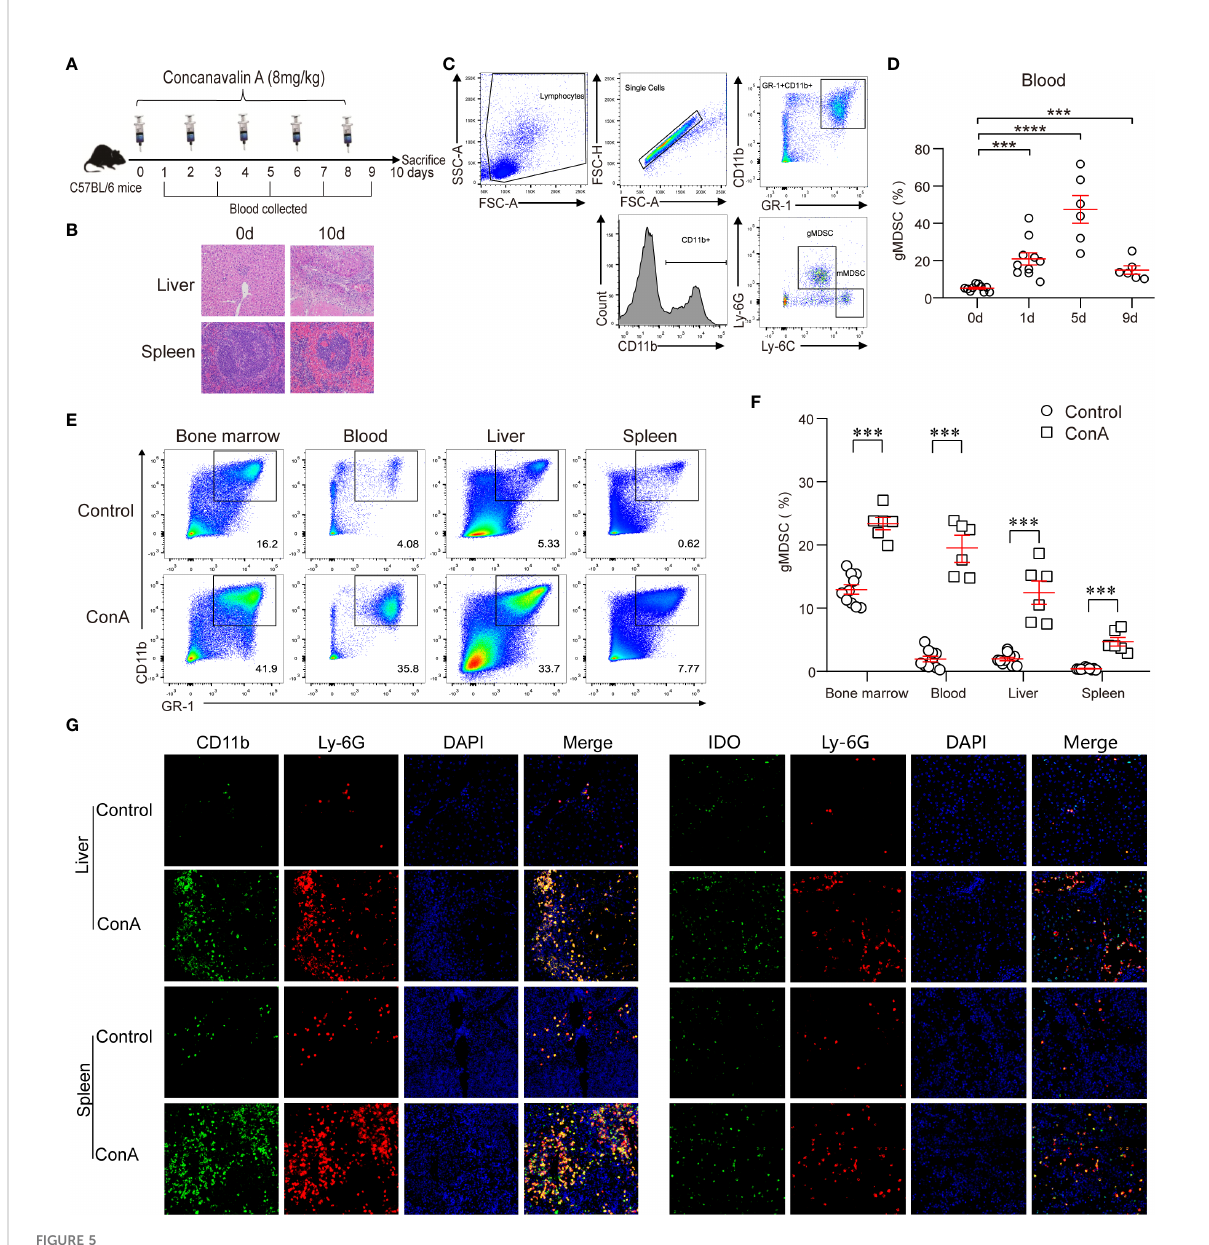
FIGURE 5 Increased gMDSC and IDO + gMDSC proportions in the ACLF mouse model. (A, B) Flow chart (A) , along with liver and spleen pathology (B) of the ACLF mouse model generated from continuous ConA injection. (C) Representative FACS plot of gMDSC and mMDSC. (D) Dynamic changes to gMDSC after continuous ConA injection. (E, F) Representative FACS (E) and cumulative dot plot (F) of gMDSC in bone marrow, blood, liver, and spleen of ACLF mice. (G, H) Representative double epitope immunostaining of liver and spleen tissue from ACLF mice for CD11b (green) and Ly- 6G (red); Ly-6G and IDO; Scale bar, 70×. ***P <.001, and ****P